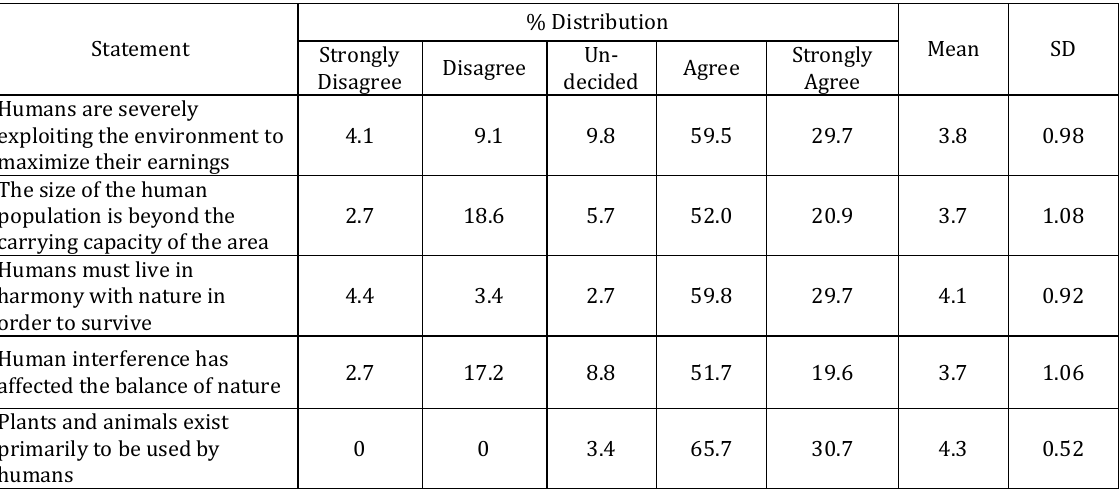
Table 6. Ecological value perceived by respondents (Source: survey, April